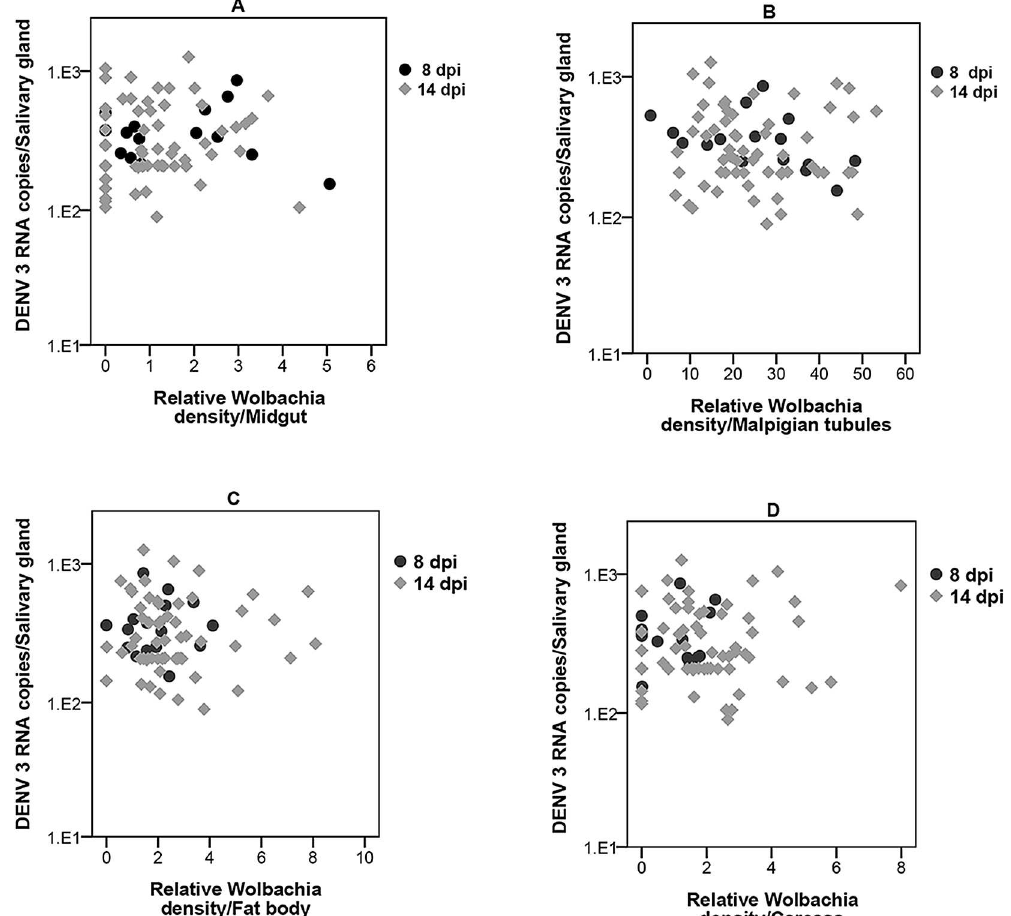
Fig 7. Correlation between Wolbachia density in tissues and DENV loads in salivaryglands. No correlation betweensalivary glands DENV loads and Wolbachia density in (A) midgut, (B) Malpighiantubules, (C) fat body, and (D)